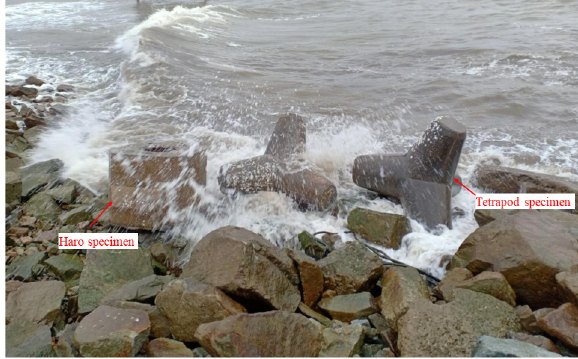
Fig. 2. Haro and Tetrapod specimen in the real marine